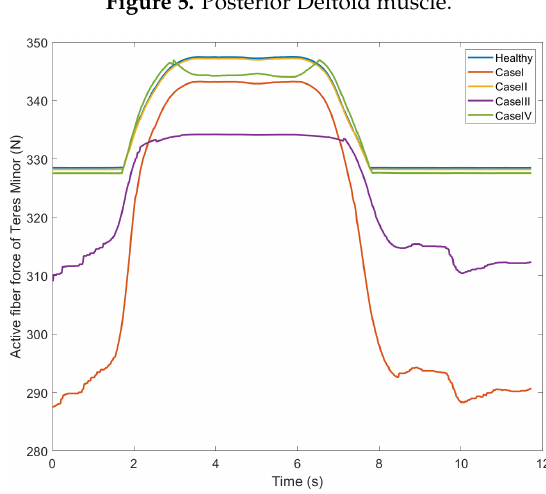
Figure 6. Teres minor